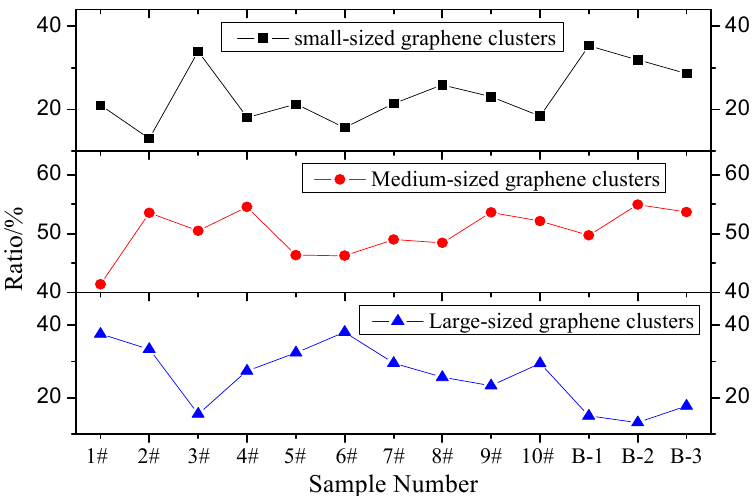
Figure 10. Variation trend of different categories of graphene clusters.